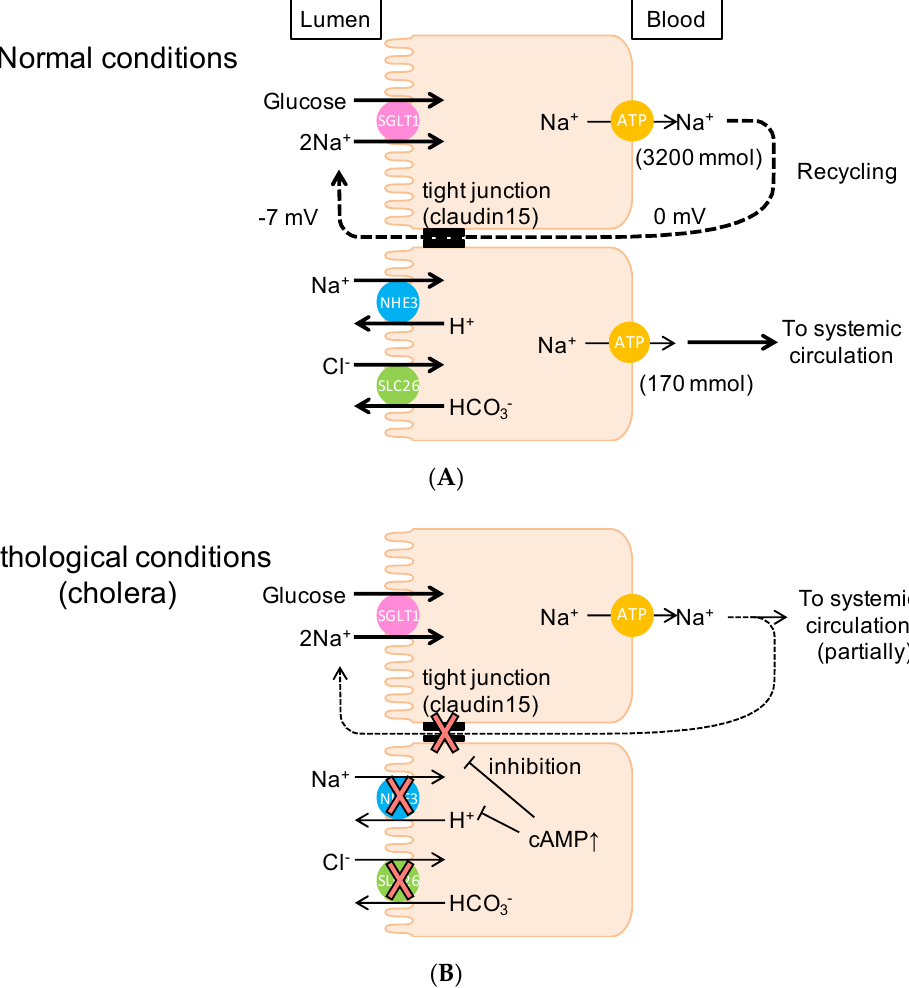
Figure 9. Schematic illustration of Na + recycling mechanisms in the murine small intestine: Under normal physiological conditions ( A ), Na + , which is absorbed with glucose, is recycled back into the lumen. However, under pathological conditions ( B ), the Na + that is absorbed with glucose can be partially transported to systemic circulation. Dashed lines indicate the Na + recirculation and the thickness of lines indicate the amount of Na + . T-bars indicate inhibition. For more detail, see Discussion.